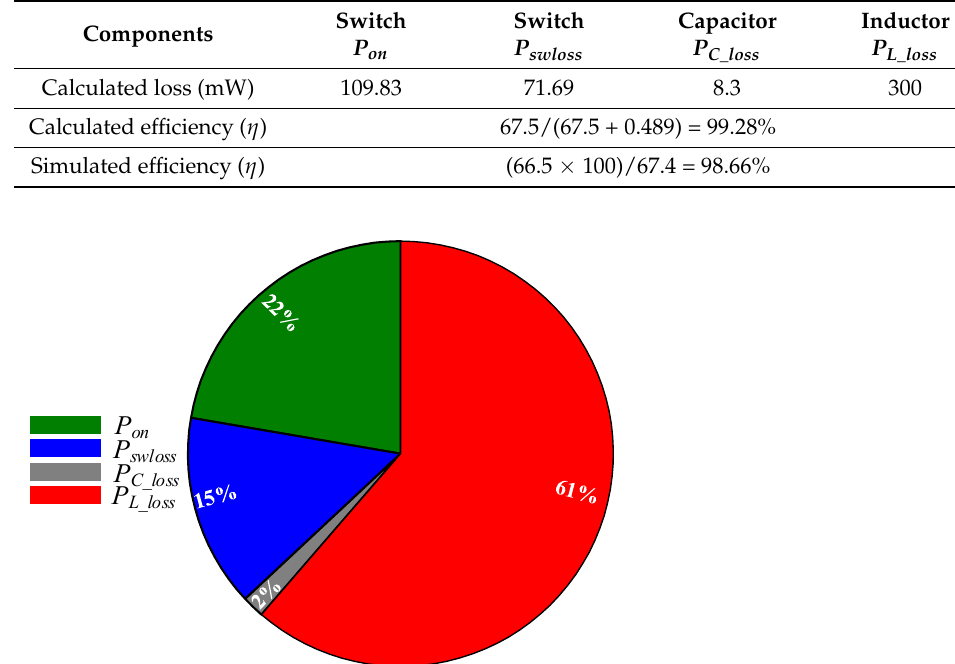
Figure 14. Theoretical analysis of power loss distribution among various components present in the proposed SCL -based DPP topology while one of the PV modules is half-shaded in Figure 5.